Question: Based on the figure, does the quantity rise or fall?
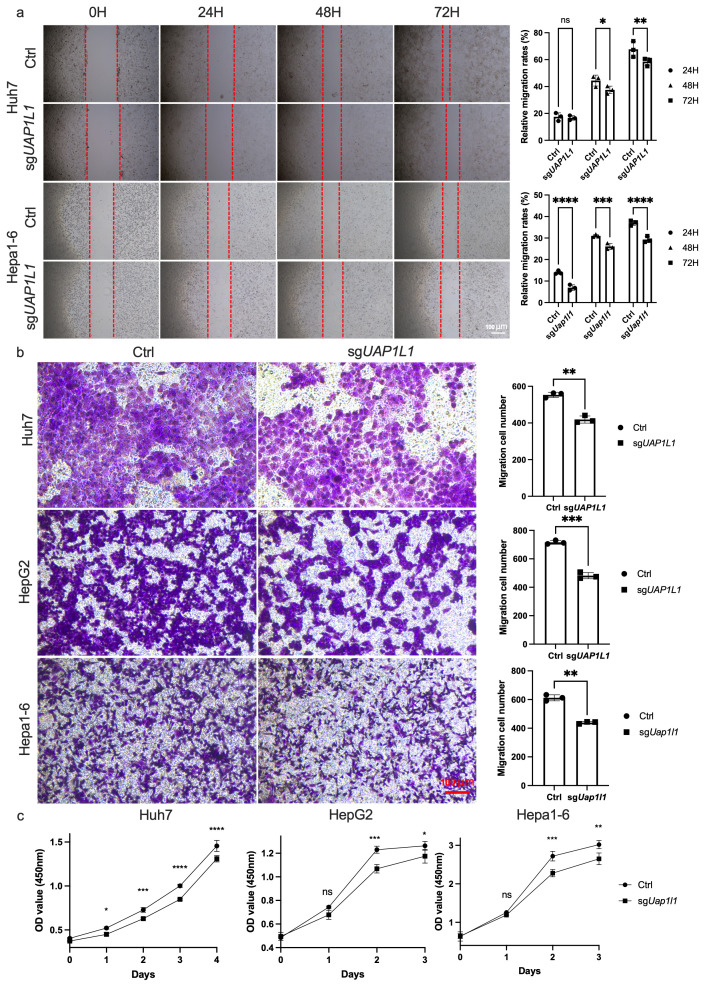
Answer: decreasing